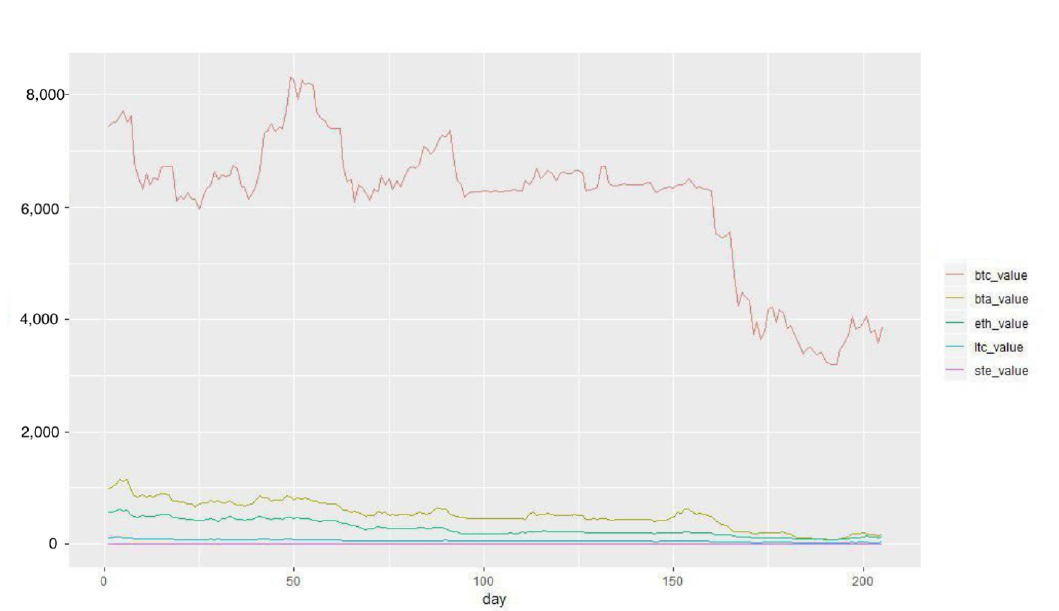
Figure 17. Value in USD of Bitcoin (btc_value), Bitcoin Cash (bta_value), Ethereum (eth_value), Litecoin (ltc_value), and Stella (ste_value) in